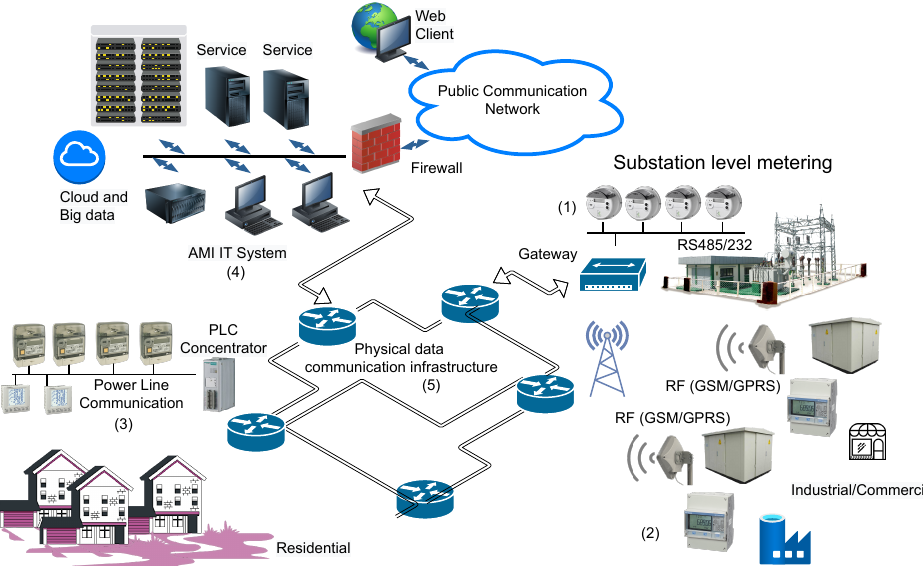
Figure 1. Typical smart metering system infrastructure. Legend: AMI IT System—Analysis Me- tering Infrastructure IT System; PLC-Concentrator—Power Line Communication Concentrator; RF (GSM/GPRS)—Radio Frequency GSM/GPRS Communication System for Residential/Industrial Smart Meters Group; RS 485/232—Serial Current Loop Communication